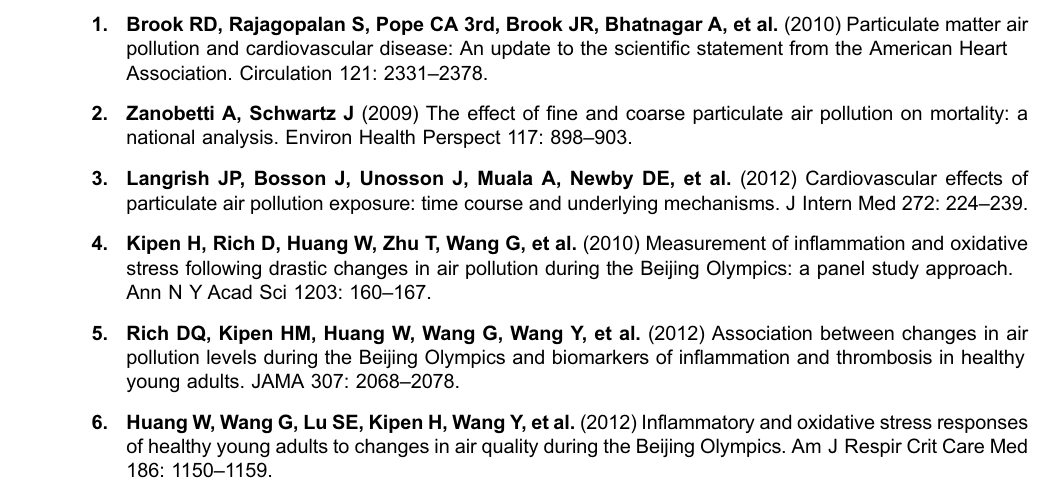
S7 Table. Estimated coefficients of pathways and the included biomarkers with PM at lag 0–6 by Stage II models. 2.5 S8 Table. Estimated coefficients of pathways and the included biomarkers with elemental carbon at lag 0–6 by Stage II models. S9 Table. Estimated coefficients of pathways and the included biomarkers with organic carbon at lag 0–6 by Stage II